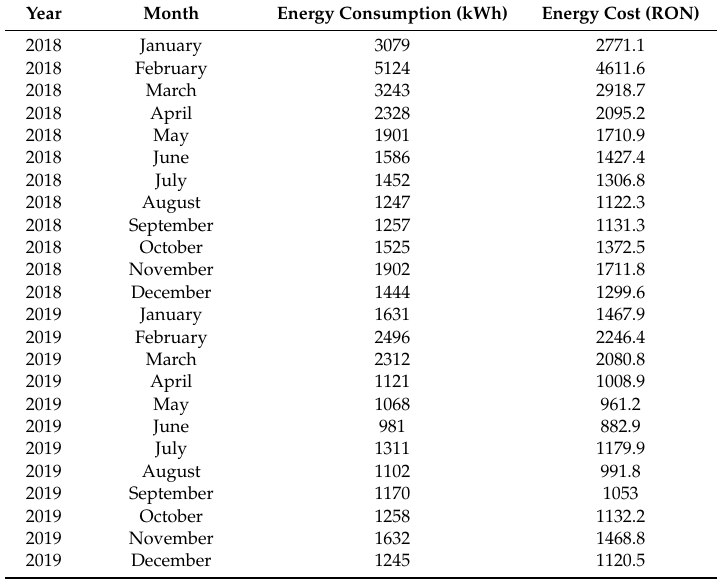
Table A1. The energy consumptions and costs in period 2018–2019 for the analysed SME.